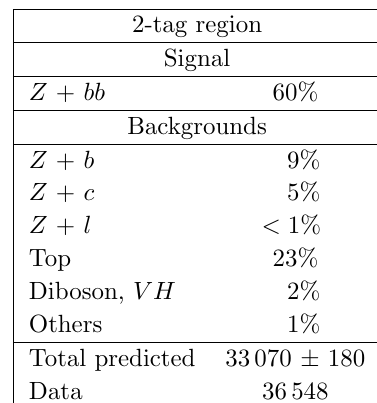
Figure 5 . Distribution of events passing the signal selection as a function of p T ;Z (left) and (cid:1) R bb (right) for events with at least two b -jets. The lower panels display the ratio of the predictions for signal plus background to data using either Sherpa (red) or Alpgen + Pythia6 (blue) as the signal simulation. The statistical uncertainty of the data is shown as black error bars and the total uncertainty of the prediction as the hatched band. The latter consists of the statistical uncertainty and all systematic uncertainties from the predictions.